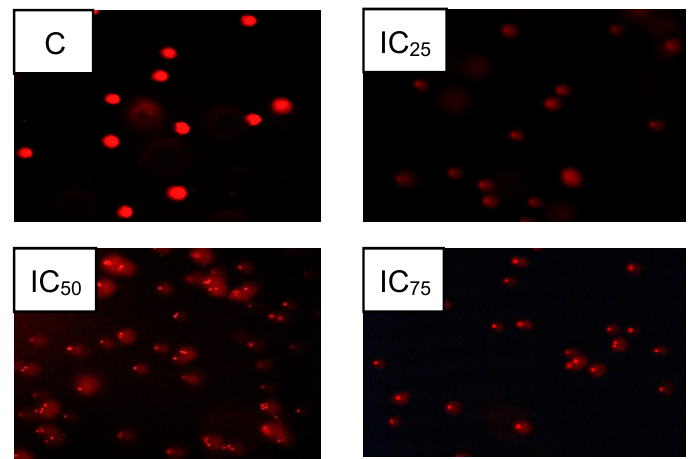
Figure 7. Degree of DNA fragmentation induced by TA in Hek-293 cells. DNA damage was increased at both IC 50 and IC 75 (63.8%) treatments relative to the control (*** p < 0.0001), with a vast 74.7% elevation in DNA fragmentation noticed at IC 50 in Hek-293 cells. A 36.4% increase in DNA damage was exhibited at IC 25 treatment (** p < 0.05) relative to the control. TA: tannic acid, C: control.